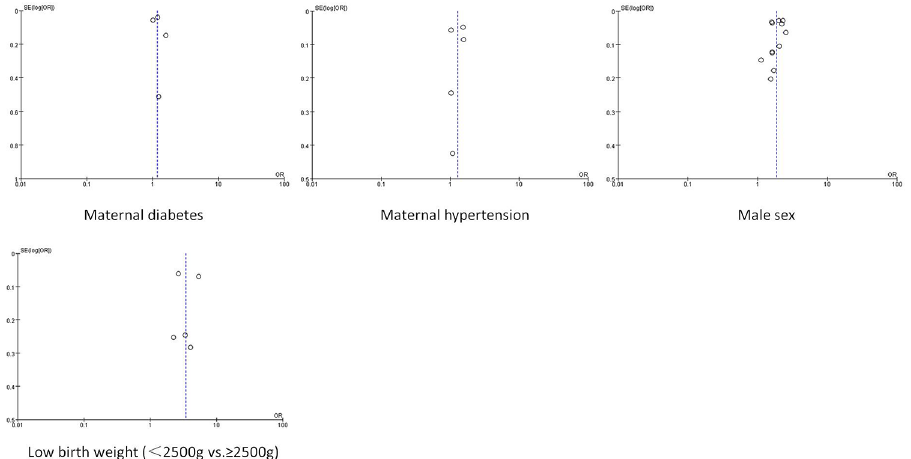
Fig 3. Funnel plot for publication bias test (Continued). The two oblique lines indicate the pseudo 95% confidence limits.